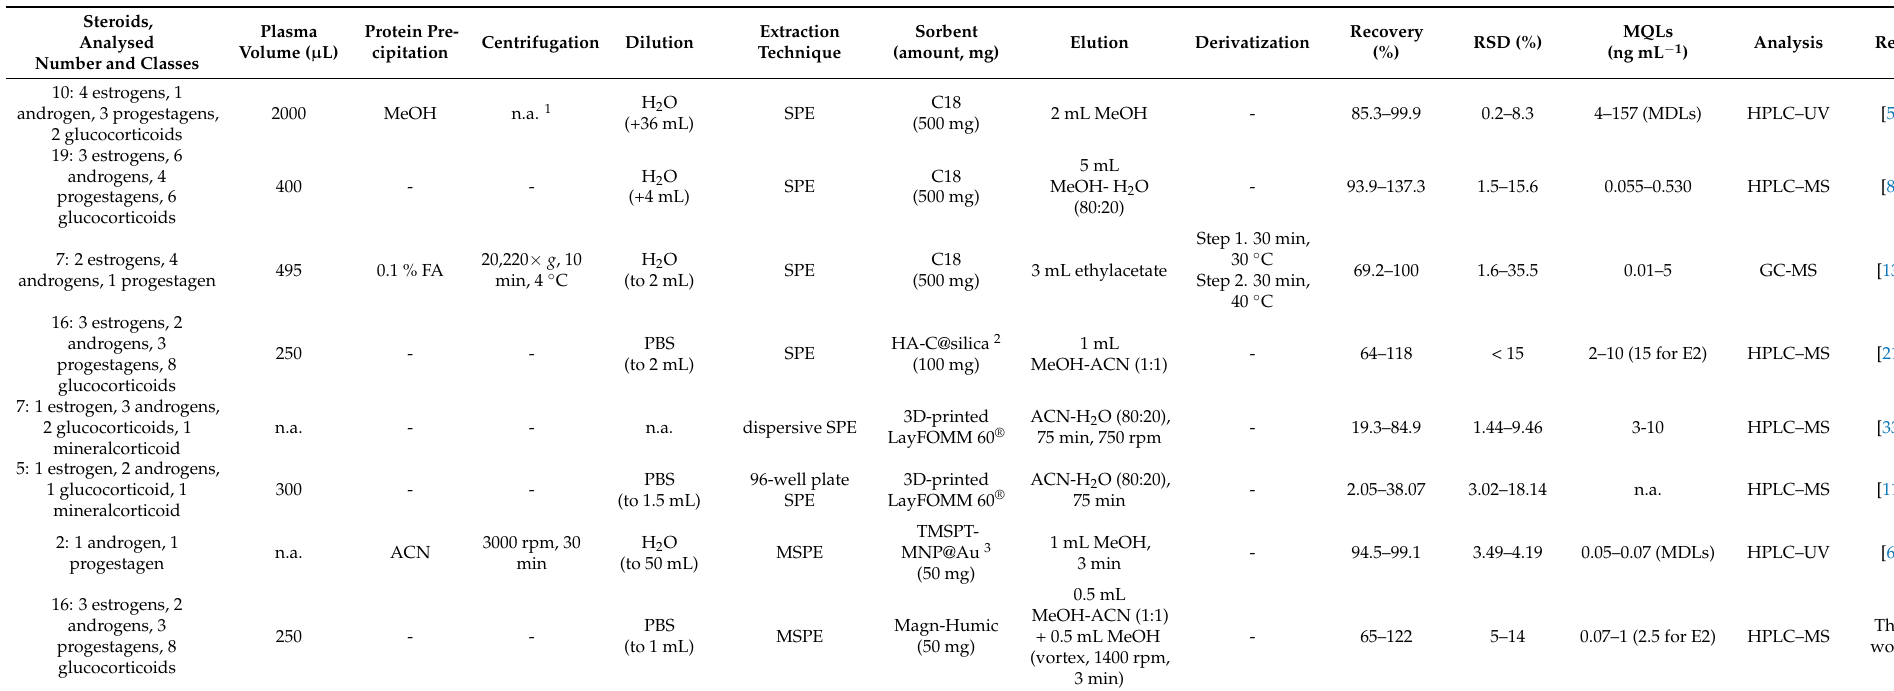
Table 5. Comparison with current analytical methods involving (M)SPE followed by chromatographic separation for steroids multiclass determination in human